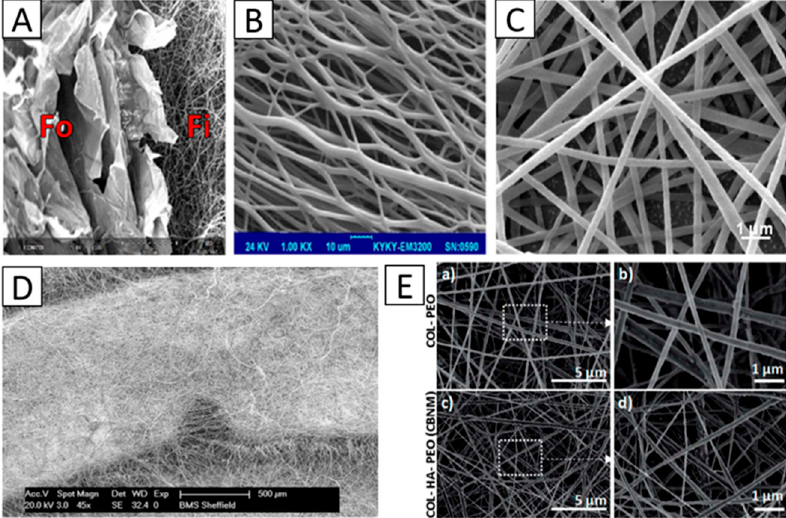
Figure 1. Scanning electron micrographs of the scaffolds. ( A ) Cross-section (foam layer on the left and fibers on the right). Reproduced from [48], with permission from © 2014 Tylor and Francis; ( B ) Oriented nanofibers of silk scaffold. Reproduced from [51], with permission from © 2015 Tylor and Francis; ( C ) Randomly oriented PCL scaffold. Reproduced from [44], with permission from © 2014 The Association for Research in Vision and Ophthalmology; ( D ) A section of the electrospun scaffold showing a horseshoe electrospun micro-pocket. Reproduced from [27], with permission from © 2012 Elsevier; ( E ) Electrospun nanofibrous membranes with binary COL-PEO ( a and b ) and ternary COL-HA-PEO compositions ( c and d ). Reproduced from [43], with permission from © 2014 The Royal Society of